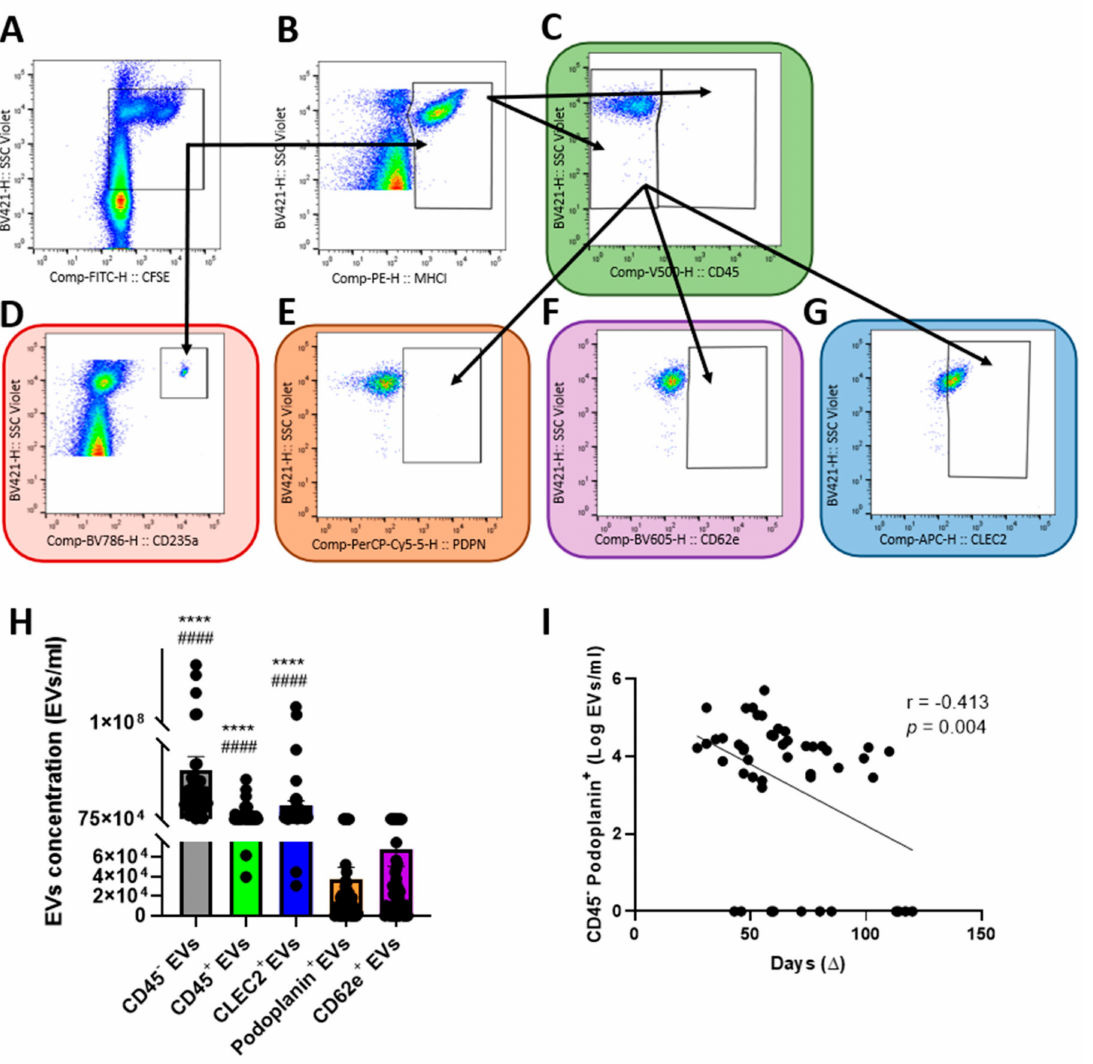
Figure 5. Characterization of extracellular vesicles and correlation with duration between onset of symptoms and donation. ( A – G ) EVs gating strategy (side scatter) for CFSE + EVs ( A ), MHCI + EVs ( B ), CD45 + EVs ( C ), CD235 + EVs ( D ), CD45 − podoplanin + EVs ( E ), CD62e + EVs ( F ) and CLEC2 +